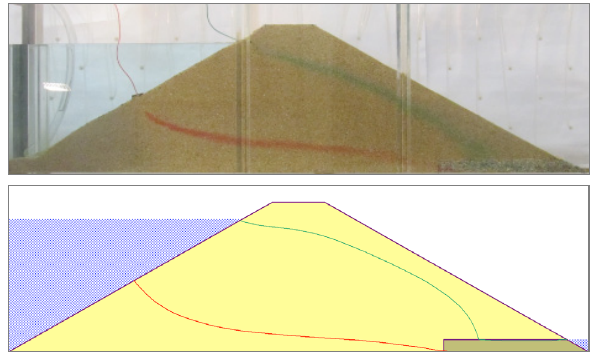
Figure 5. Experimental and numerical results for flow line configura- tion in small scale dam with toe